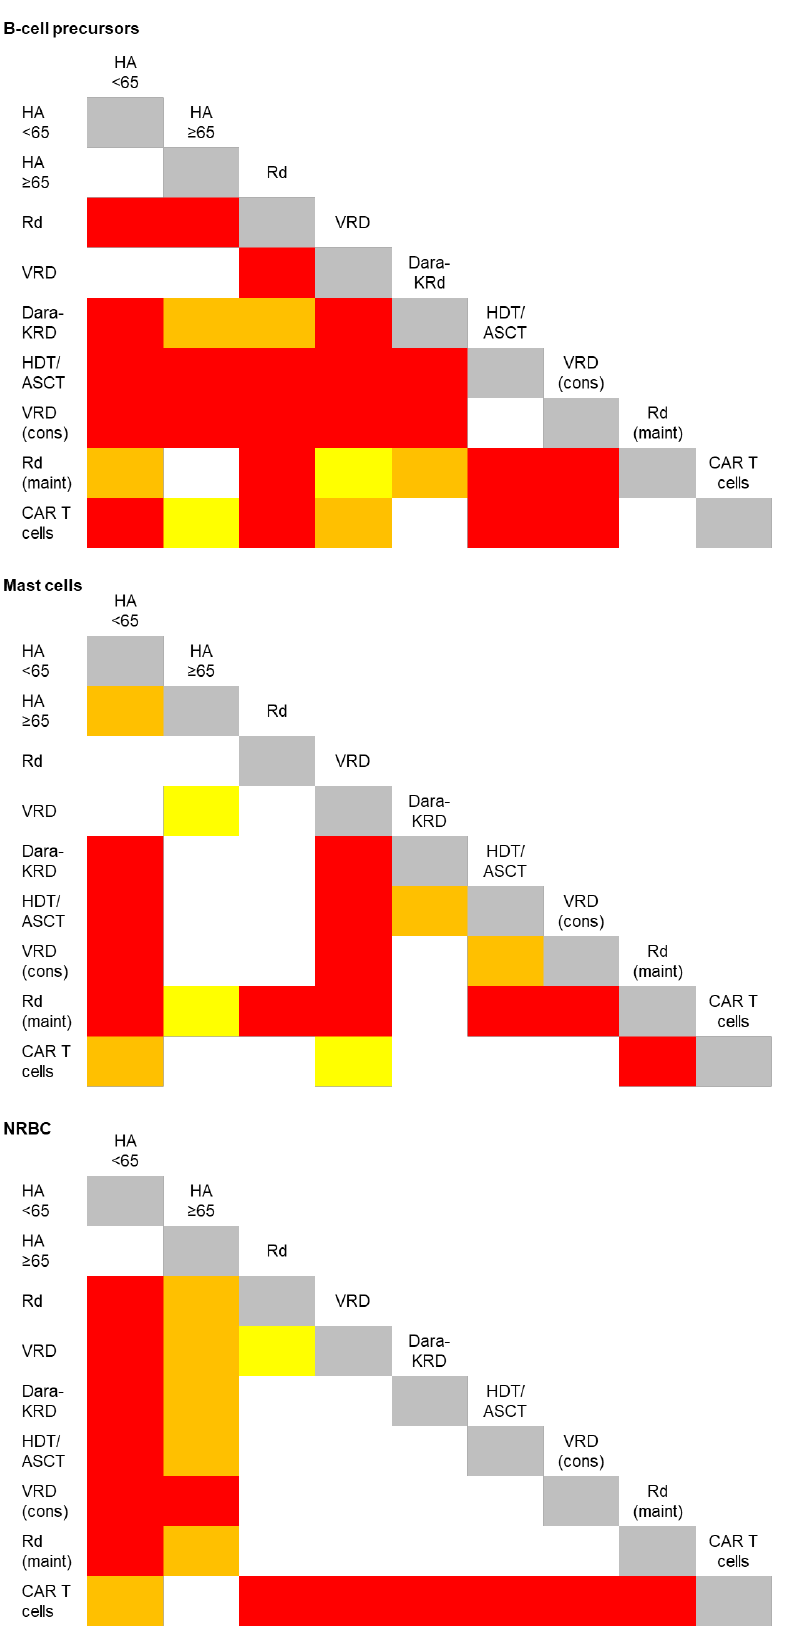
Figure 2. Graphical representation of significant differences in the frequency of B-cell precursors, mast cells and nucleated red blood cells (NRBC) in bone marrow aspirates from healthy adults (HA)